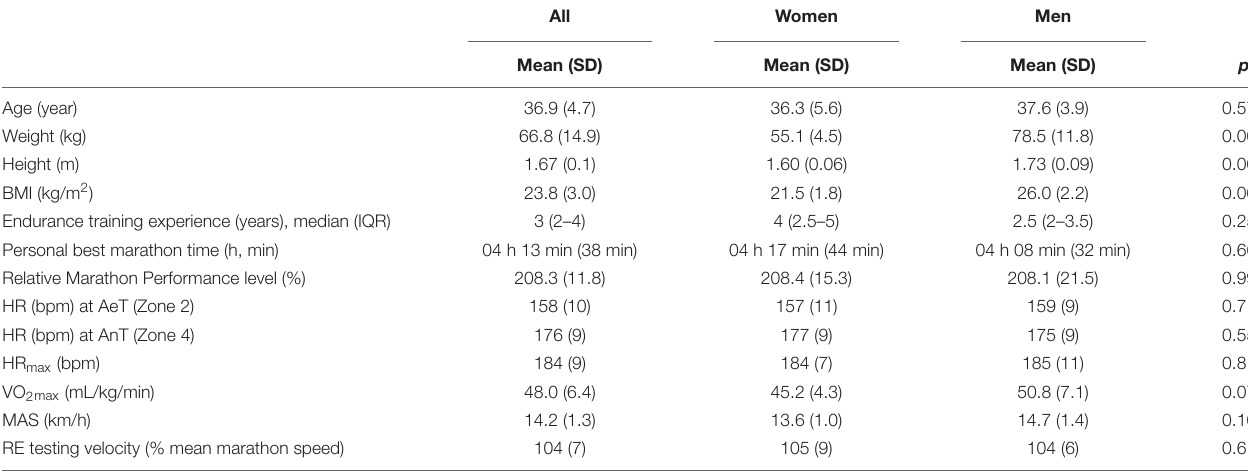
TABLE 1 | Sample characteristics.